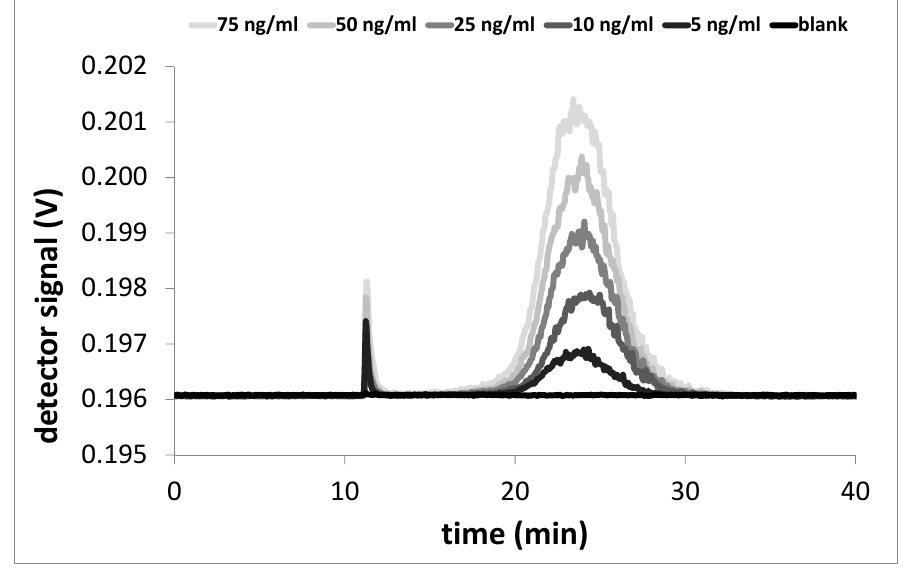
Figure 3. Asymmetrical Flow Field-Flow Fractionation/Multi-Angle Laser Light Scattering (AF4/MALLS) fractograms of PX 80 dispersed in 96% ethanol (1 mL injection, 92° detector).